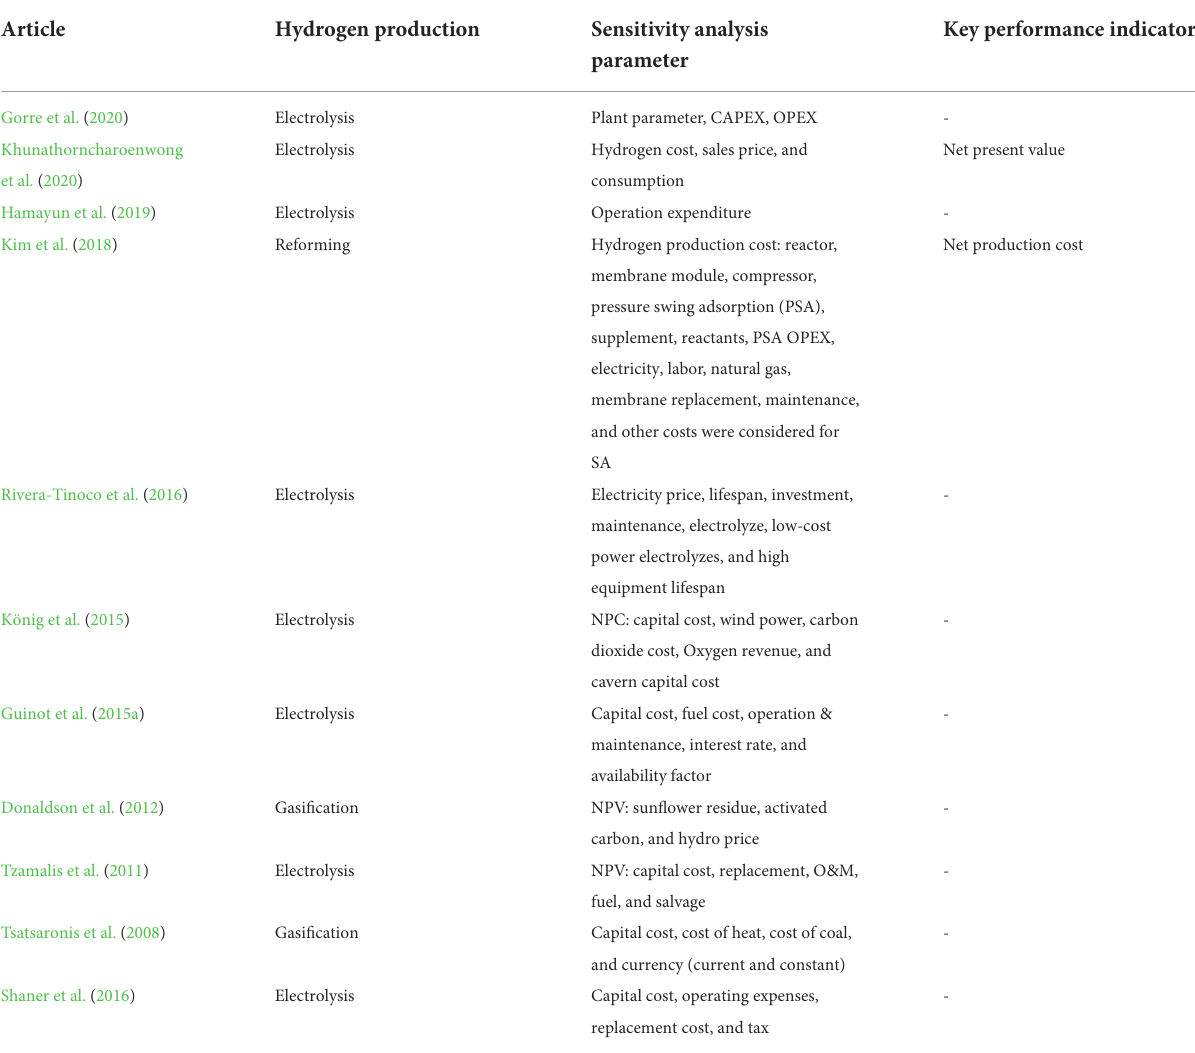
TABLE 1 Summary sensitivity analysis